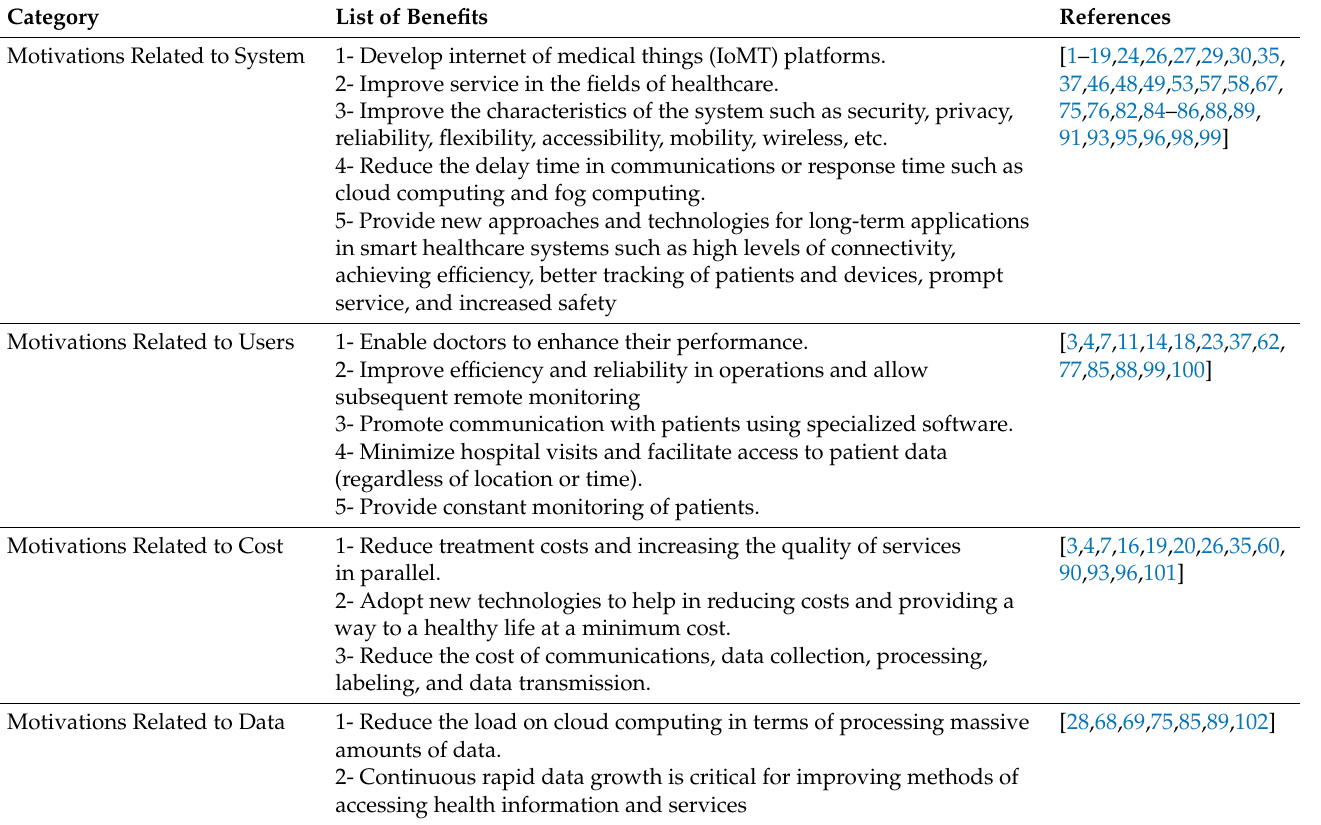
Table 2. Summary of common motivations.